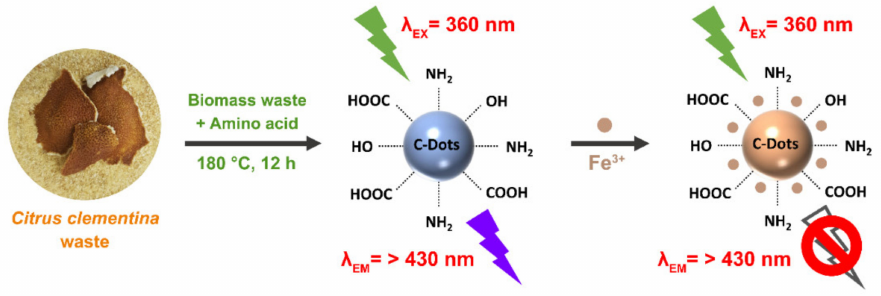
Figure 8. Schematic illustration of CQDs preparation and their application in Fe 3+